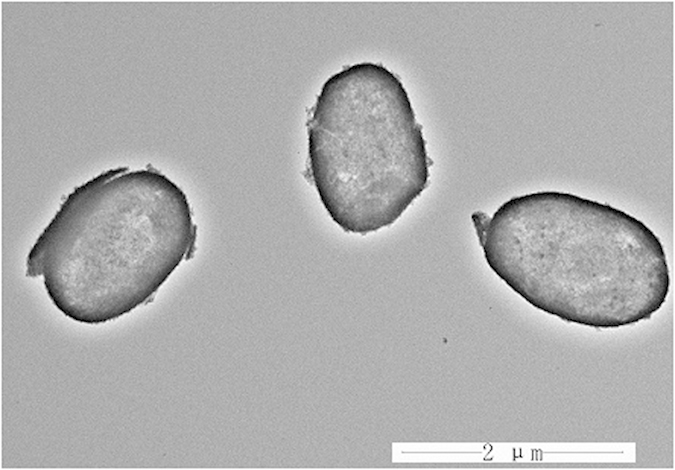
TEM image of hybrid hollow SnO2@TiO2 nanocapsules electrodes after 200 cycles at 1 C.